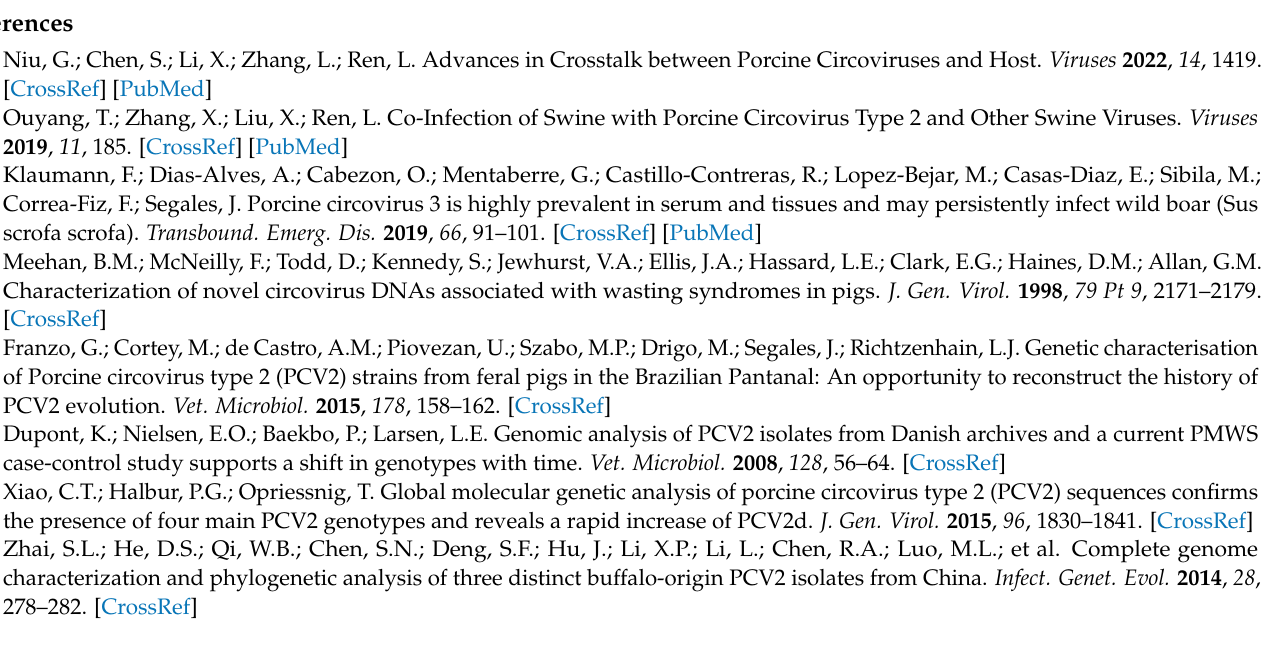
Figure S1: Predicated 3D structures of PCV2 Cap and Rep proteins from different